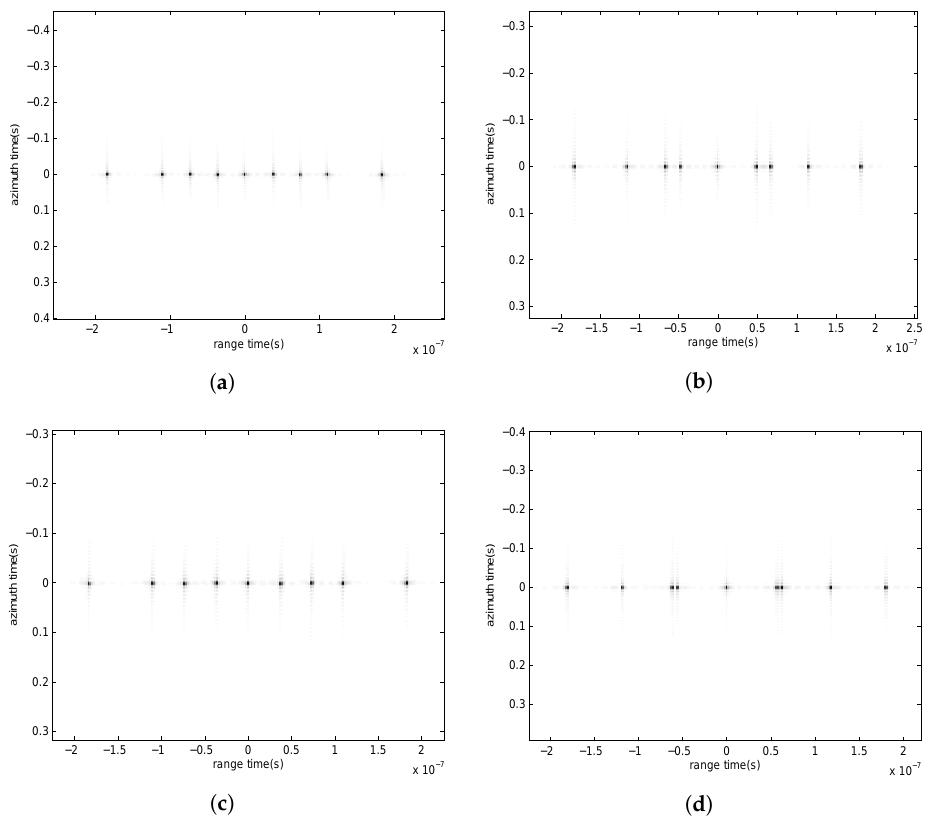
Figure 12. Focused images. ( a ) The focused image of the first T/R pair; ( b ) the focused image of the second T/R pair; ( c ) the focused image of the third T/R pair; ( d ) the focused image of the fourth T/R pair.